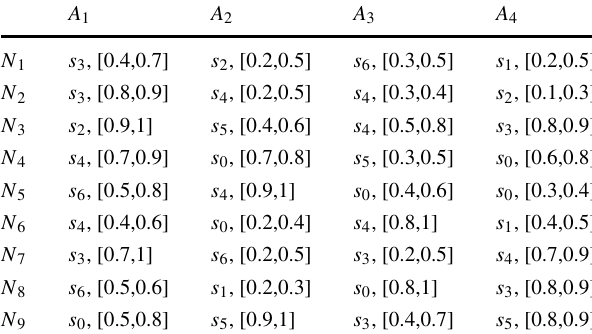
Table 5 The decision matrix with confidence interval values according to the fourth voting node